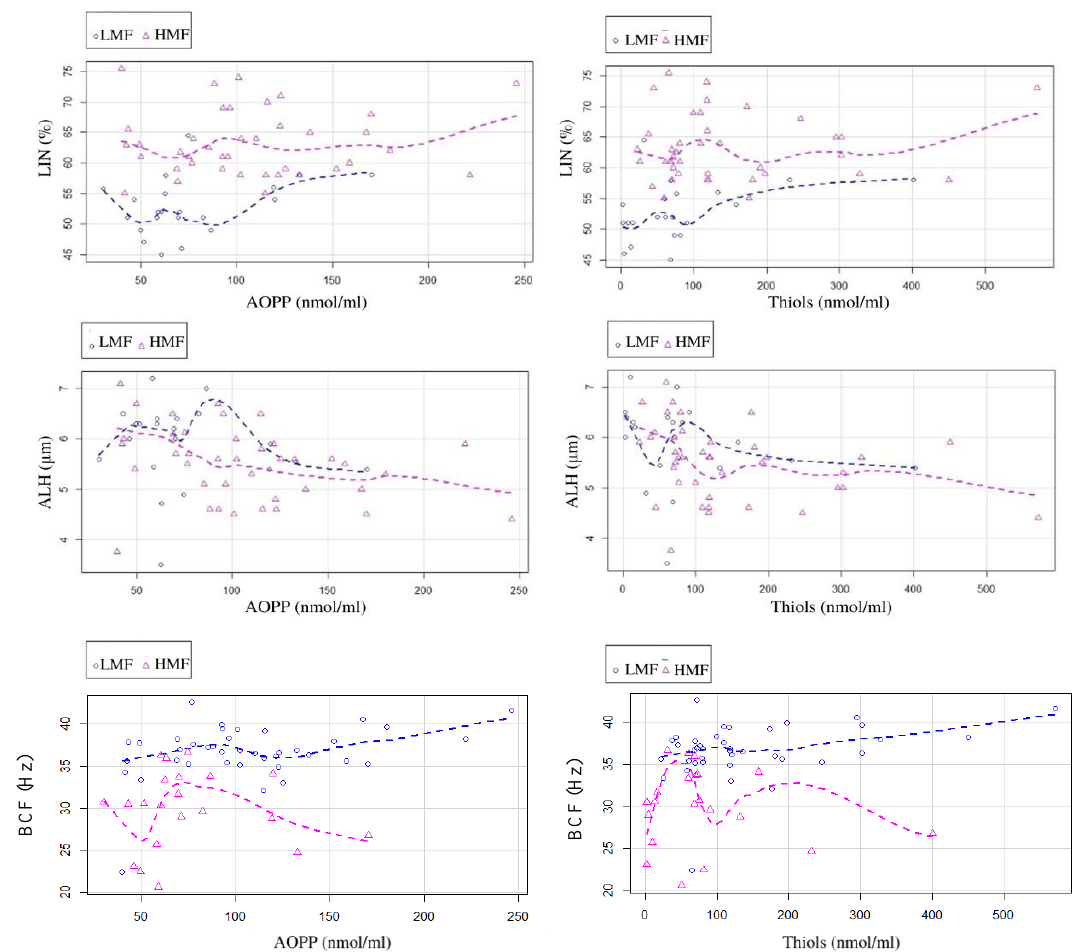
Figure 2. Scatter plot representing the relation among the oxidative stress markers, AOPP and thiols, of seminal plasma and the motility parameters, LIN, ALH, and BCF.